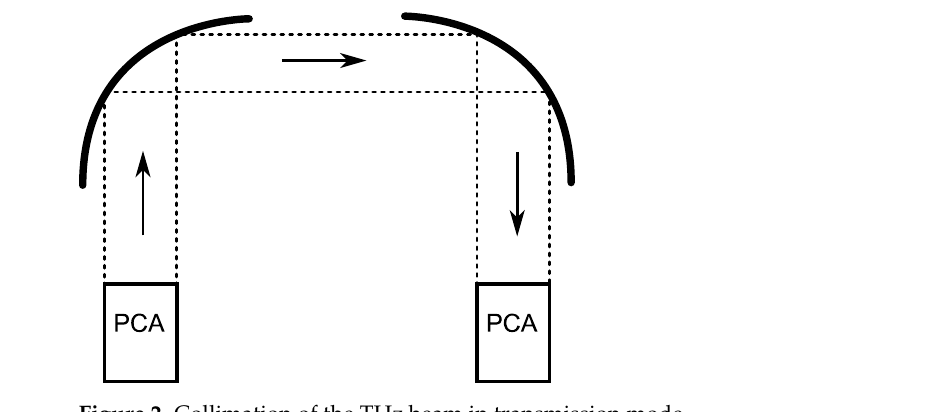
Figure 2. Collimation of the THz beam in transmission mode.